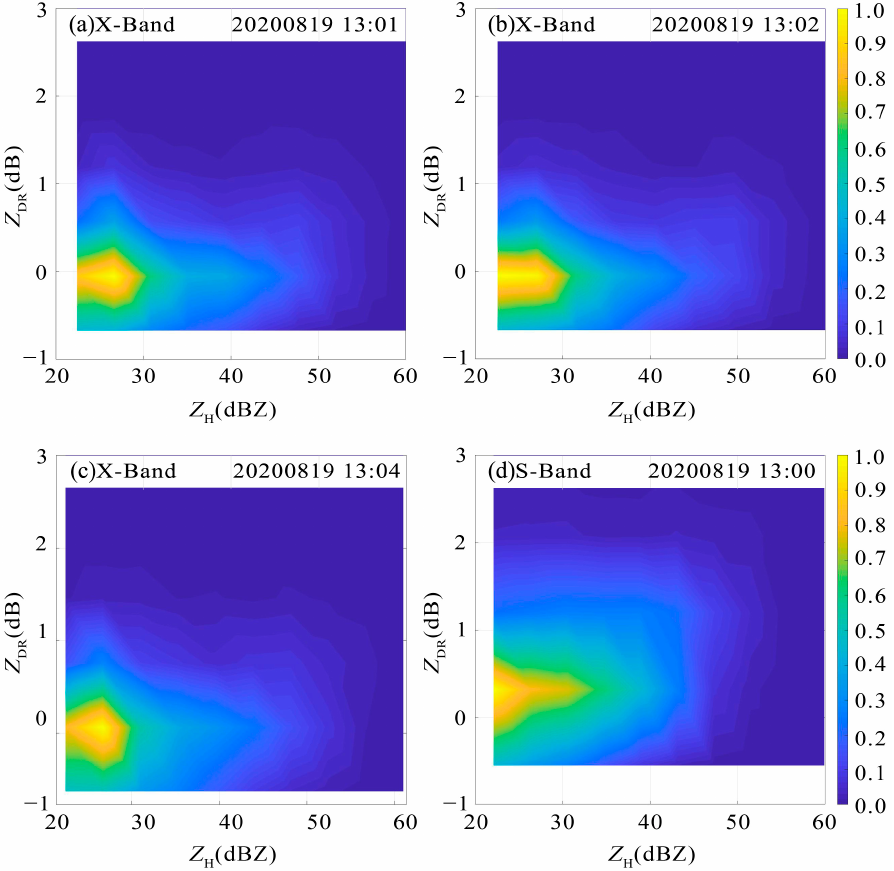
Figure 11. The normalized density of Z H - Z DR. in the Typhoon Higos rainband observed by the Nansha X-band PAR at ( a ) 13:00, ( b ) 13:02, ( c ) 13:04, and ( d ) the S-band radar at 13:00 on 19 August 2020.